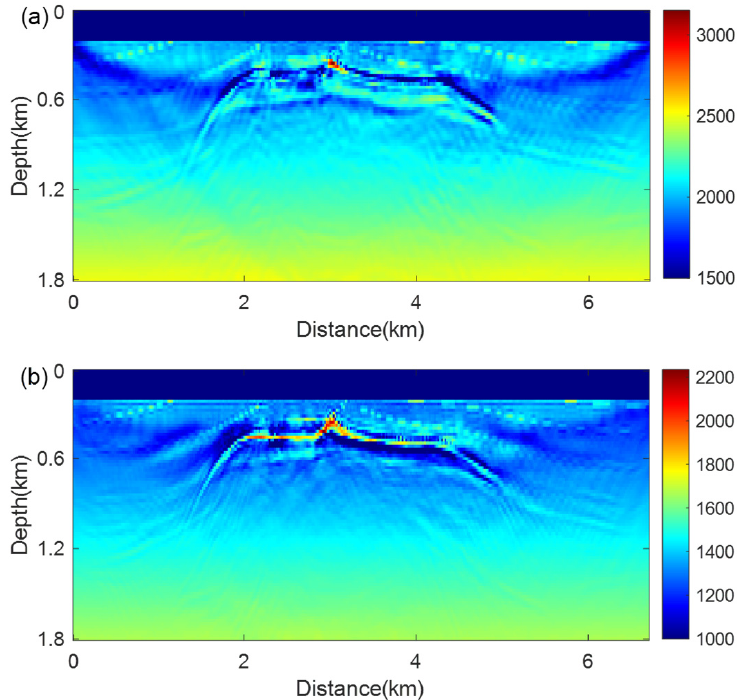
Figure 4. Initial velocity model. ( a ) Initial Vp model; ( b ) Initial Vs model.